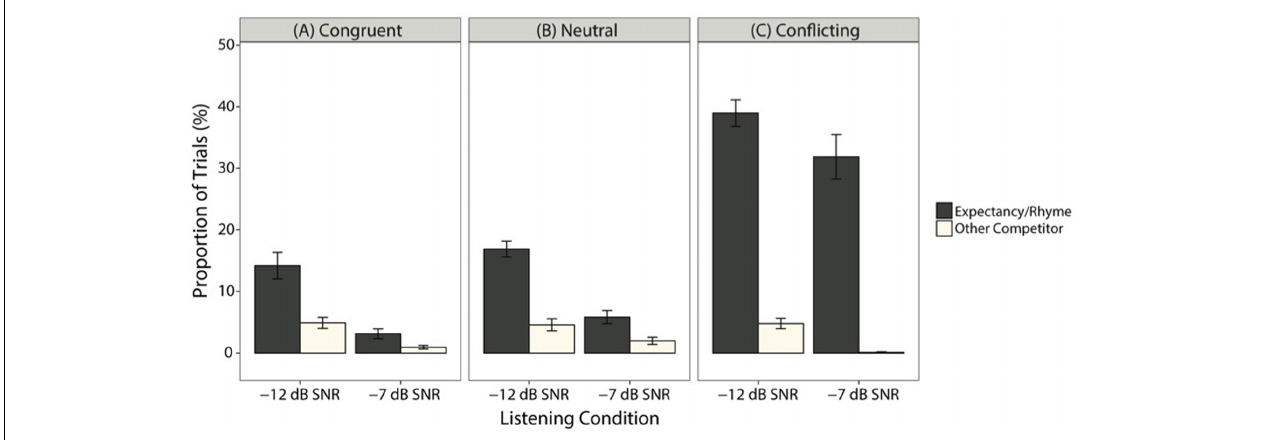
FIGURE 5 | The mean ( ± SE) proportion of each error type out of total number of trials for each listening condition, averaged across subjects. (A–C) shows proportion of each error type for the congruent, neutral, and conflicting expectancy conditions,